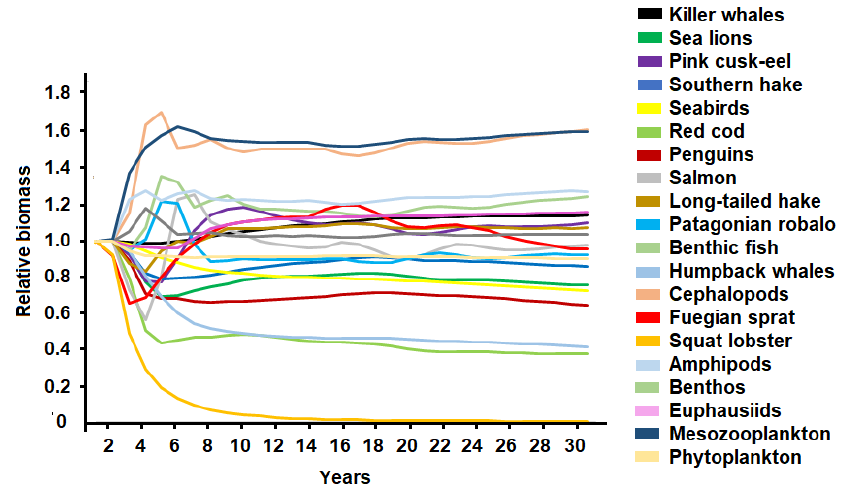
Figure 6. Changes in the relative biomass of the functional groups of the ecosystem when simulating the fishing extraction of 25% of the biomass of squat lobster and Fuegian sprat.